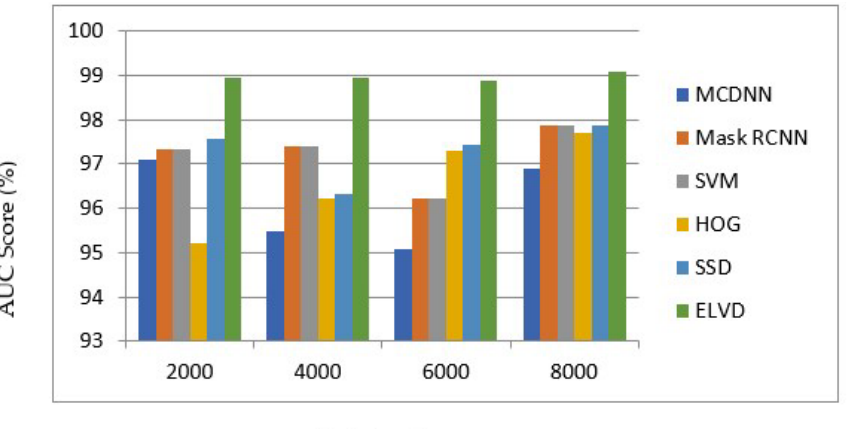
Figure 13. Comparative analysis with AUC% with Different State-of-the-Art Techniques.